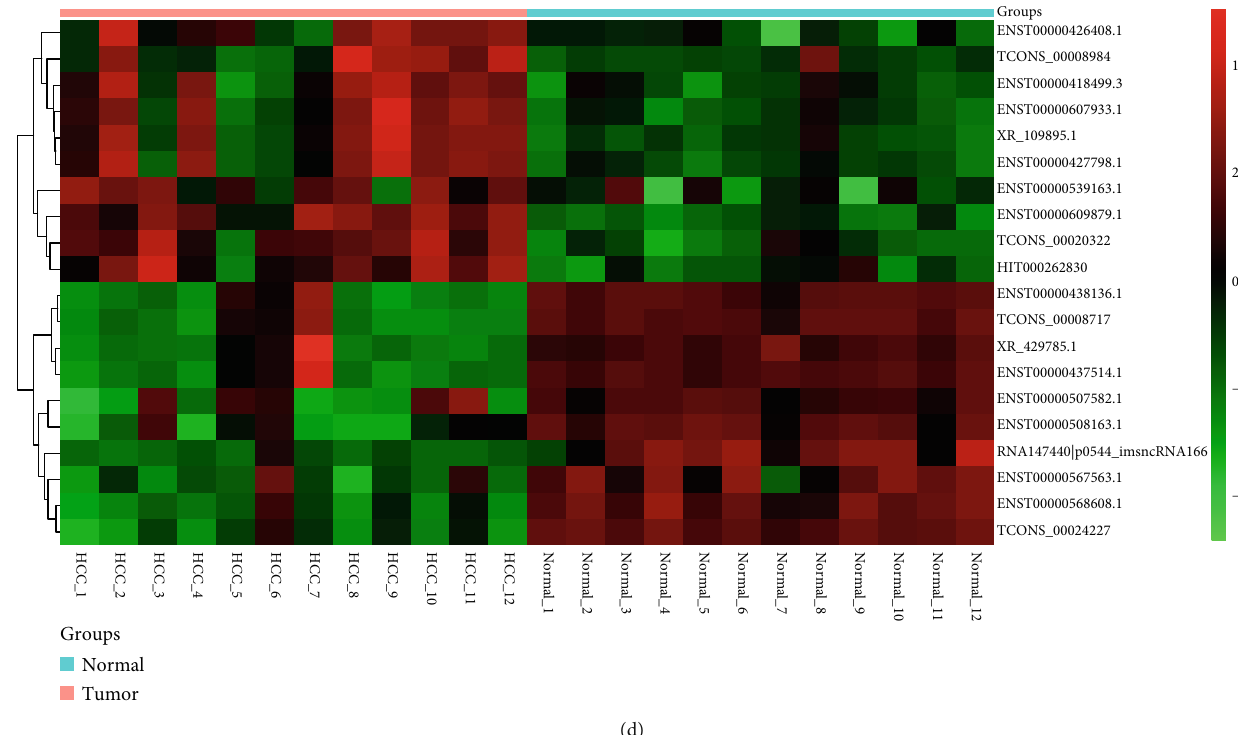
Figure 2: Identi fi cation of di ff erentially expressed lncRNAs. Box plots show the distribution of the relative lncRNA expression in each sample before (a) and after (b) normalization of GSE115018. (c) Volcano plot of di ff erentially expressed lncRNAs. Di ff erentially expressed lncRNAs were screened with criteria of adjusted P value < 0.05 and ∣ log2fold − change ð FC Þ ∣ ≥ 1 . (d) The cluster heat map of the top 10 upregulated and downregulated